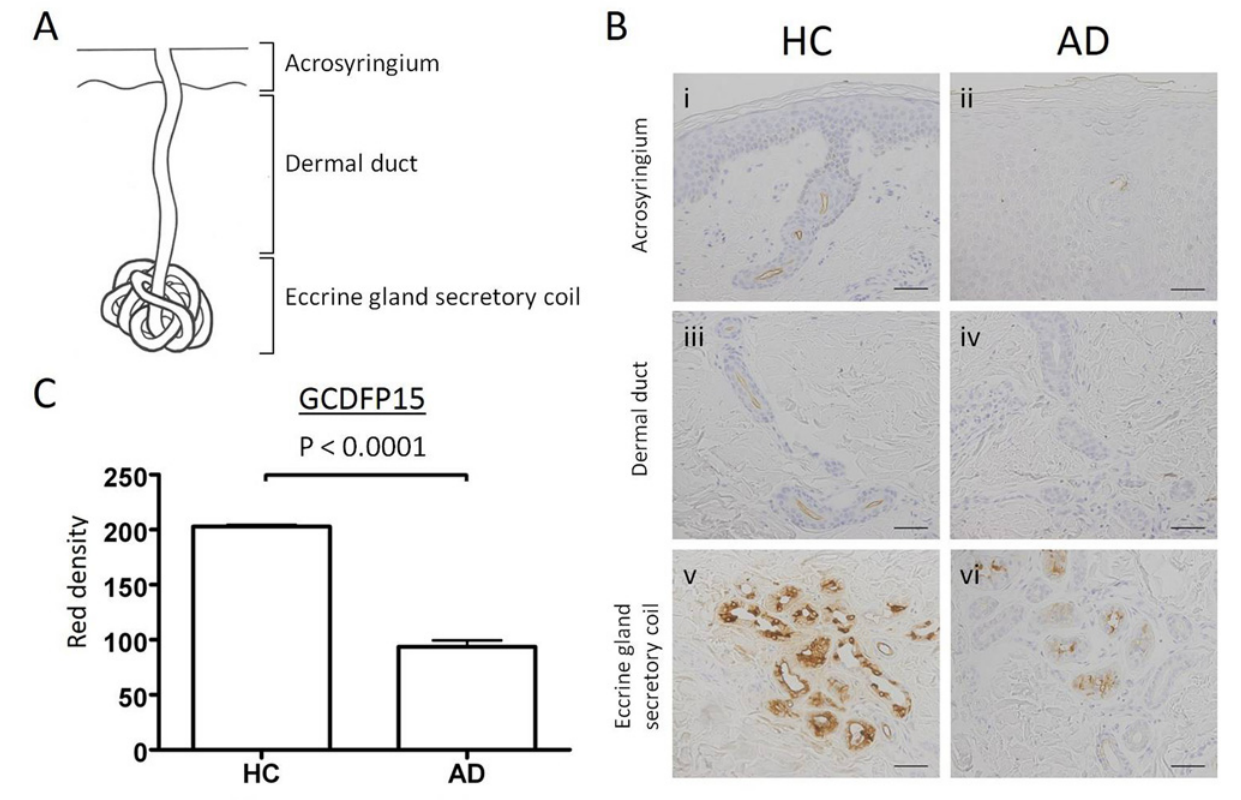
Fig 2. Immunohistochemical staining for GCDFP15 in eccrine sweat glands of normal and atopic dermatitis skin specimens. (A) Eccrine sweat glands are composed of eccrine gland secretory coil, dermal duct, and acrosyringium. (B) Normal and AD skin specimens were immunohistochemically stained with anti-GCDFP15 antibody. Bars indicate 50 μ m. (C) The staining intensities are expressed as red density (RD). The RD of GCDFP15 in the eccrine gland secretory coil is significantly lower in AD patients. Results are expressed as mean ± SEM.